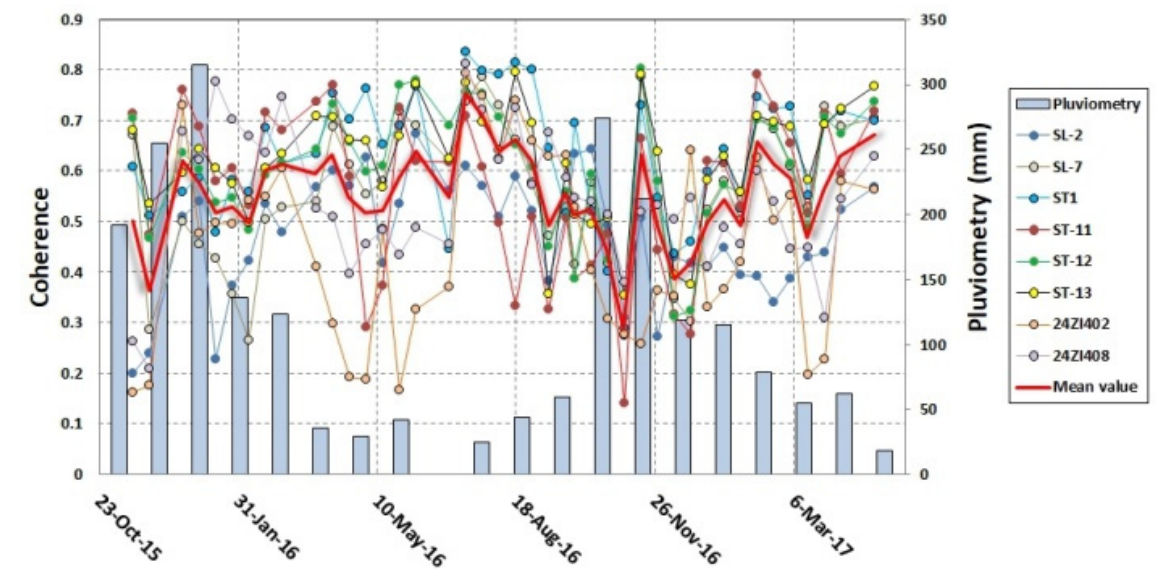
16 Figure 10. ( a ) View from the East edge of the Tulipa dike, with the Germano Reservoir on the oppo- site side (West), ( b ) position and direction from which the photo was taken, as well as the locations of the prisms ST-11 and ST-12. It was noticed that the values of the topographic surveying results were very noisy for the prisms 24ZI402 and 24ZI408 (Figures 8 and 9). In both of these prisms, the mean value of the vertical and horizontal decomposed MPs’ measurements followed the TS measurements in great parts of the time series, while the TSX projections did not match with the TS values’ intervals. The S1 projected values overestimated the deformation in the vertical direction (Figure 9). It is important to emphasize that not all of the MPs’ (projected and decomposed) val- ues obtained exceeded the nominal TS measurements error (±8 mm), reaching the expec- tations of the geotechnical team of the SAMARCO Company. The standard deviation values for the vertical decomposition measures showed sim- ilar values to the topographic survey. The standard deviation for the TSX-projected meas- urements was about 64% higher, for the S1-projected vertical measurements the values were lower than the topographic survey. Analyzing the standard deviation mean values for the decomposed horizontal meas- urements, the decomposed horizontal, TSX-Proj and S1-proj values were better than those of the topographic survey, due to the multi-looking processing. It is important to point out that the period of November 2016 to February 2017 was in the rainy season in the study region, which reached an accumulated rainfall of 280 mm, which increased the standard deviation values of the topographic survey and the DInSAR results.